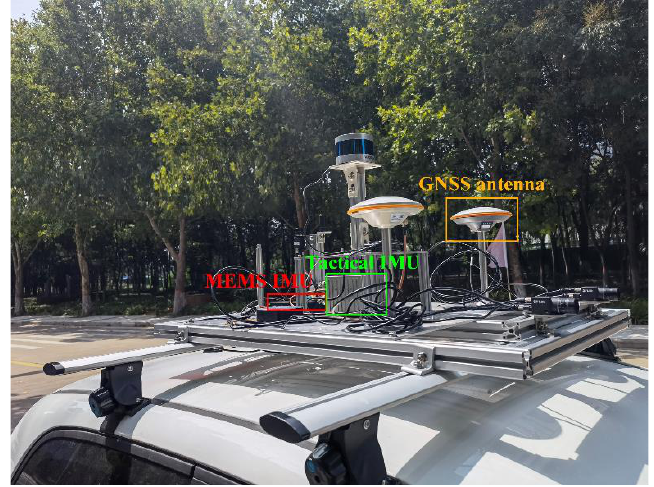
Figure 2. Vehicle − mounted platform of the experiment.